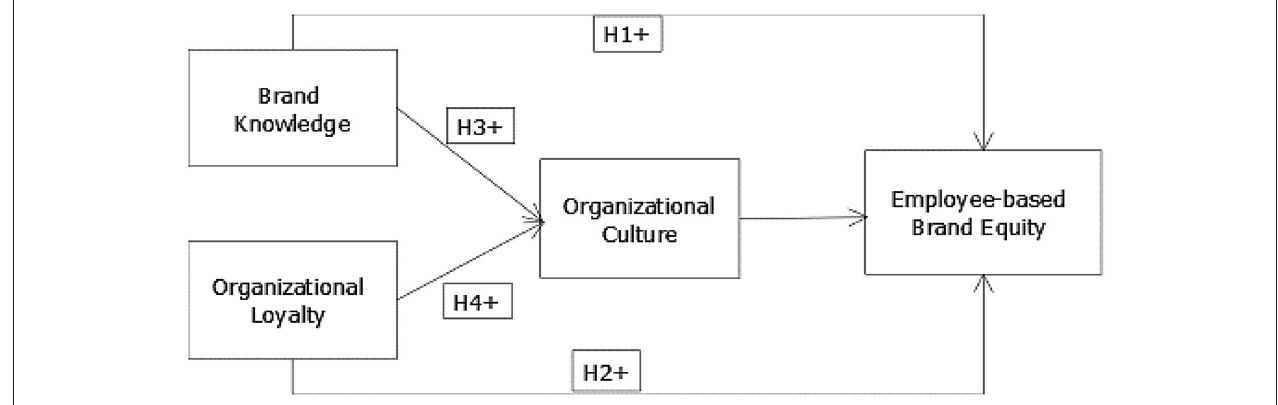
FIGURE 1 | Conceptual